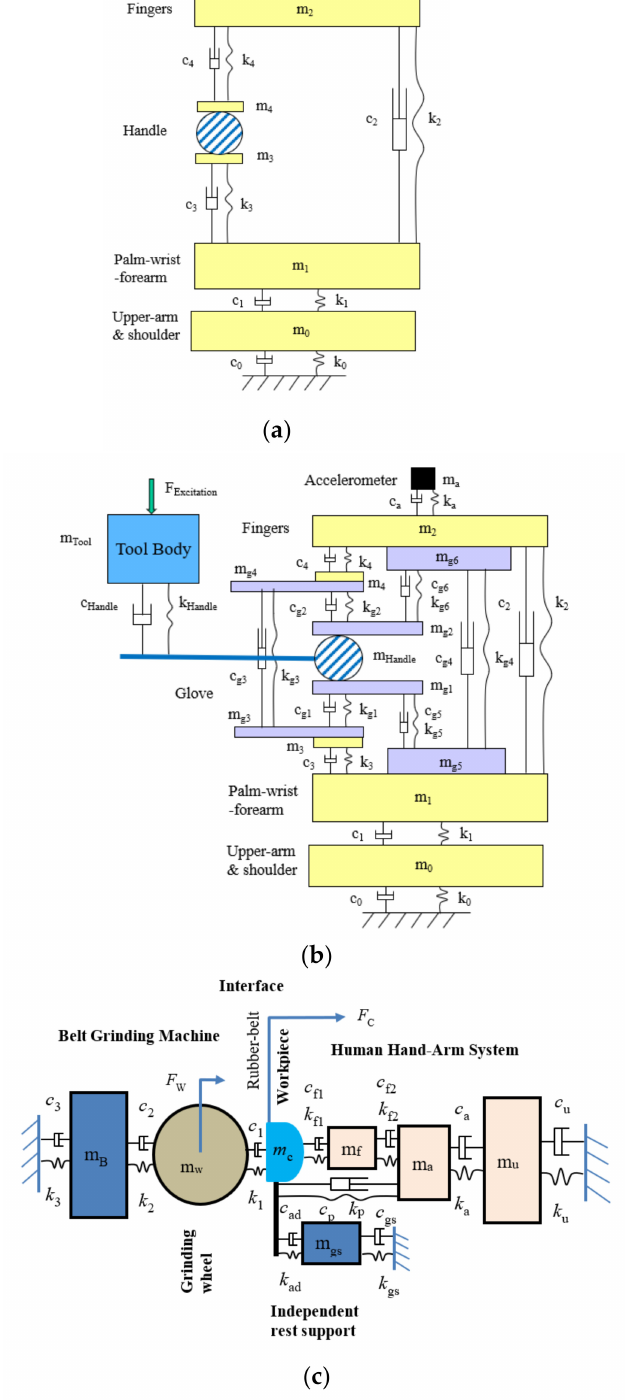
Figure 6. The lumped-parameter models of the hand–arm system developed by NIOSH researchers: ( a ) a model of the hand–arm system [71]; ( b ) a model of the entire tool–handle–glove–hand–arm system [77].; and ( c ) a model of grinding-machine–workpiece–hand–arm system